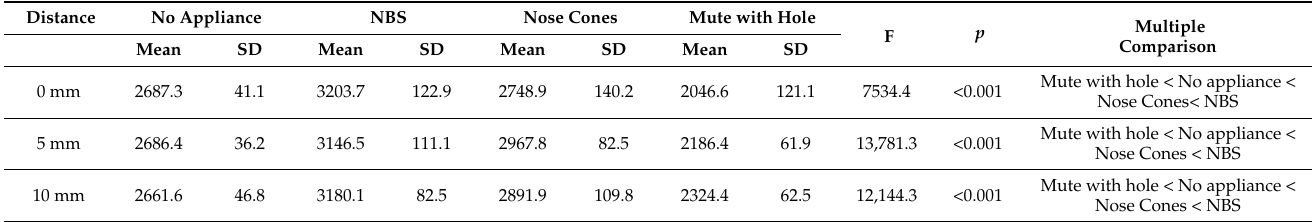
Table 1. The change in velocity for each appliance.